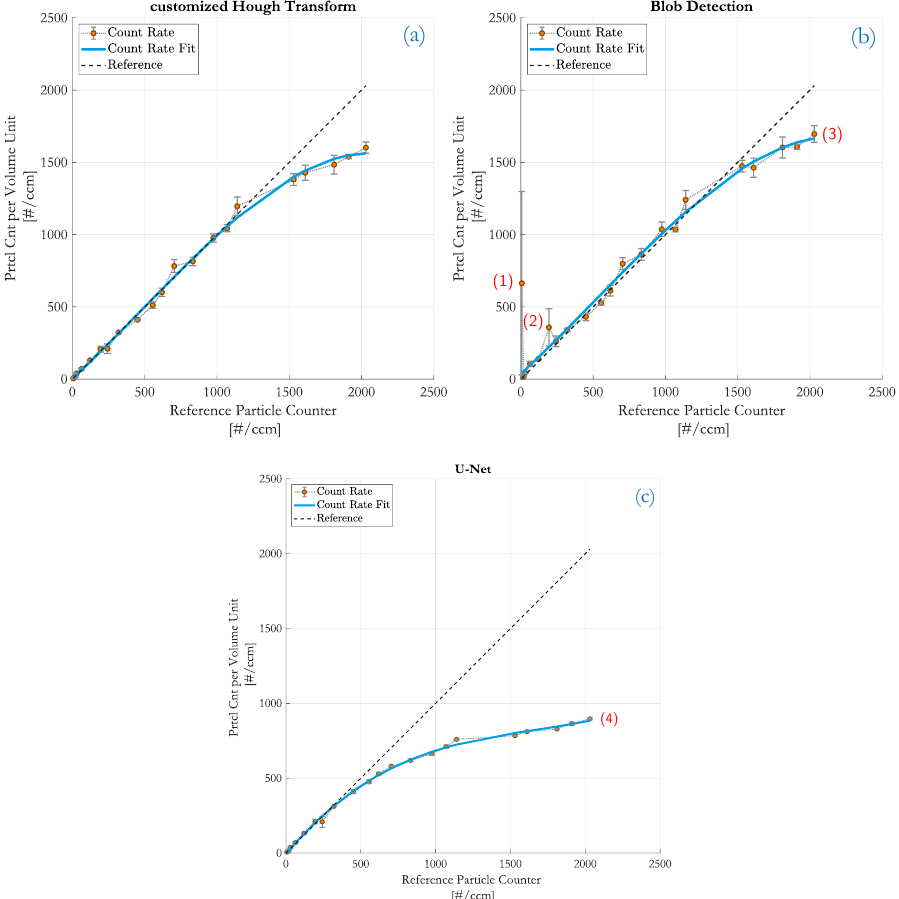
Figure 7. Comparison of the monitored particle number concentration to the counting rates obtained by the PIU. ( a ) customized HT; ( b ) blob detection with maximum entropy thresholding; ( c ) DCNN based on a